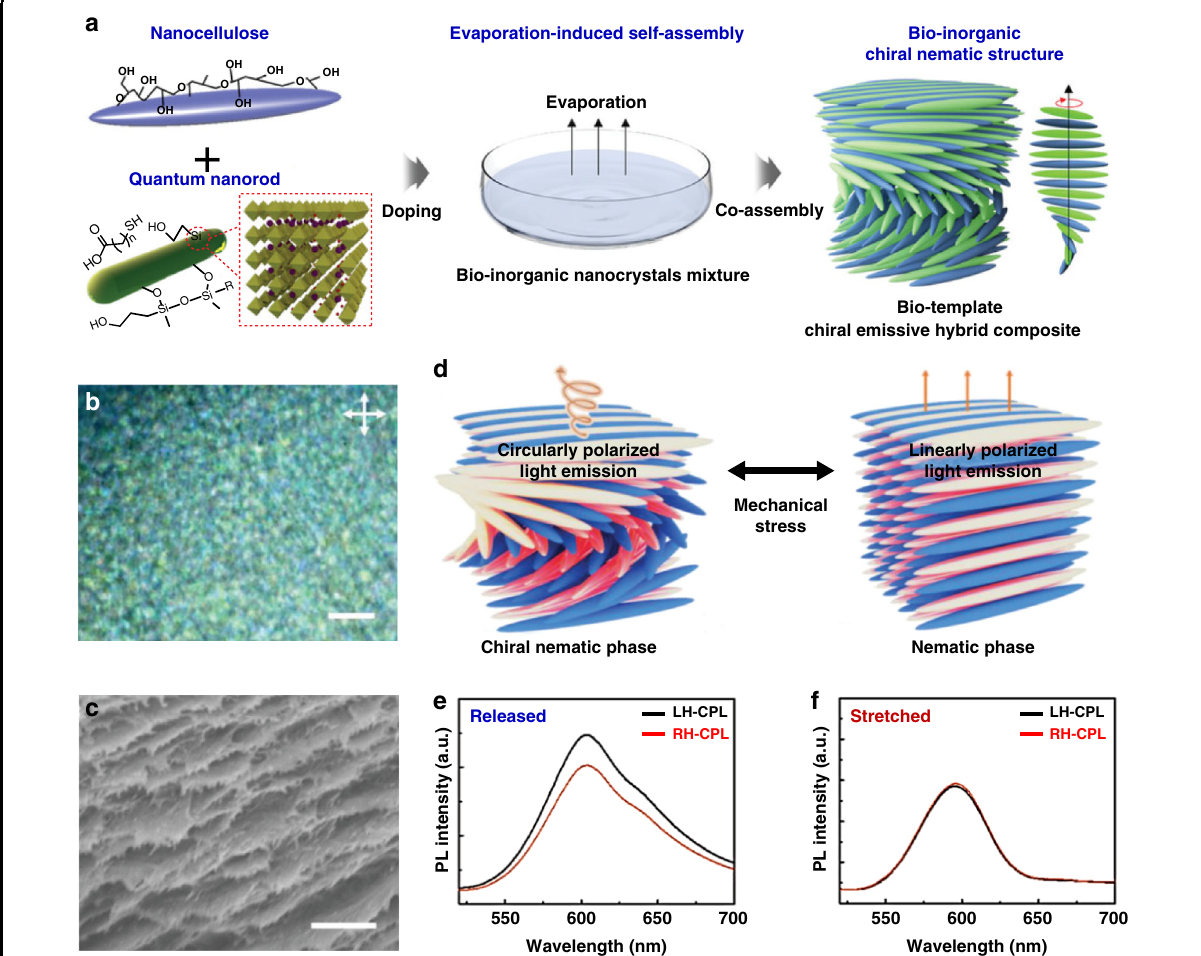
Fig. 7 Chiral luminescent nanomaterials prepared from the co-assembly of CNCs and quantum nanorods. a Schematic process of fabricating chiral luminescent nanostructured fi lm via evaporation-induced self-assembly. b Polarized optical microscope image of the chiral luminescent nanostructured fi lm (Scale bar, 10 µm). c Chiral luminescent nanostructured fi lms exhibiting chiral nanostructures. (Scale bar, 1 µm). d – f Mechanically driven polarization modulation of emitted light from CPL to linearly polarized emission. Reproduced with permission from ref. 250 . Copyright 2021,